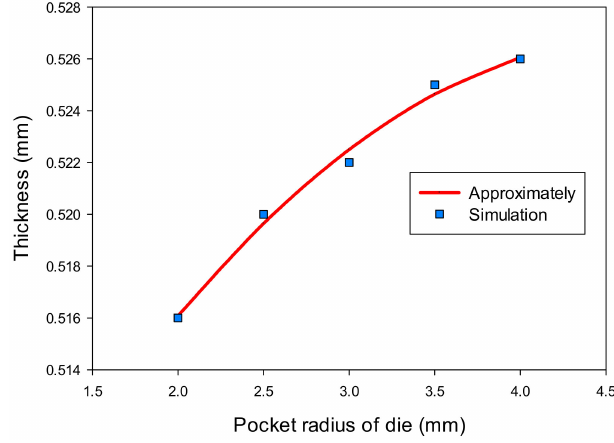
Figure 13. The effect of pocket radius of die on thickness.